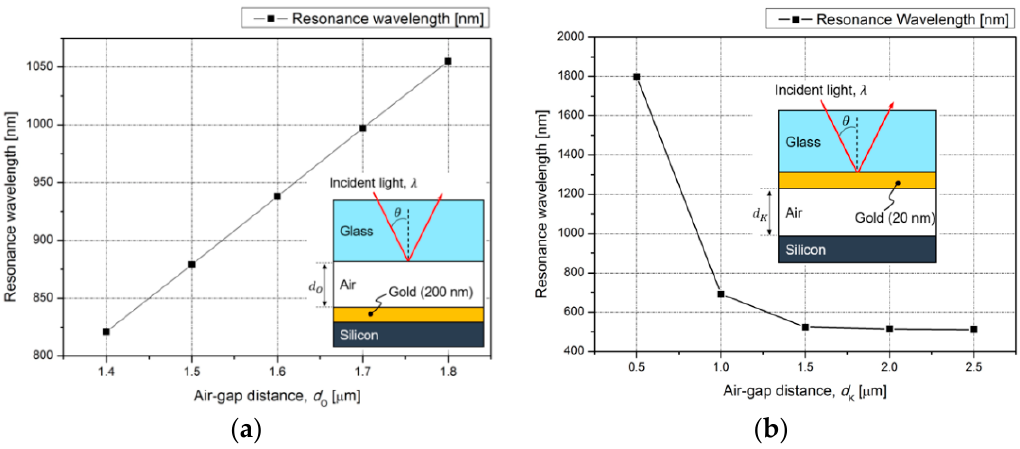
Figure 2. SPR resonance wavelength according to the air-gap distance: ( a ) Otto configuration; ( b ) Kretschmann configu- ration.